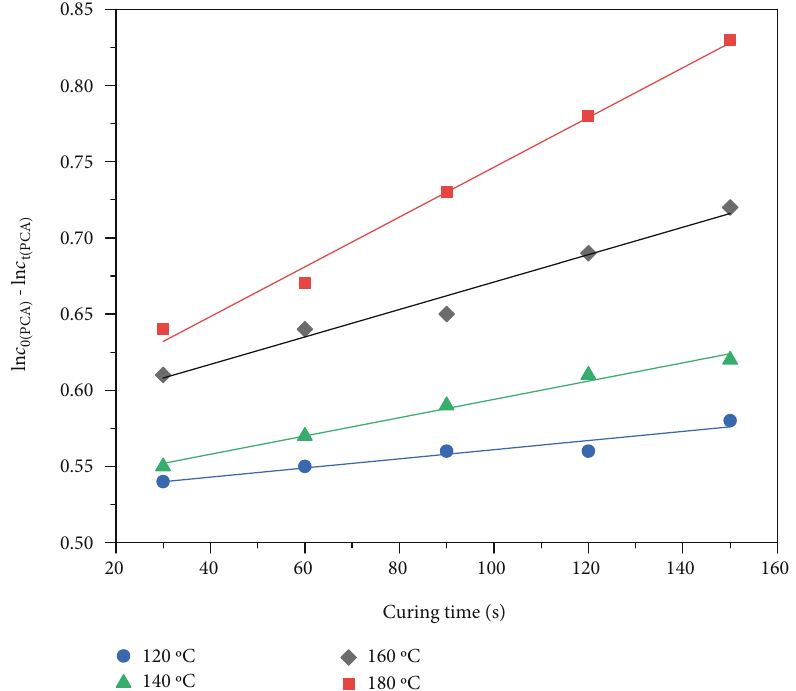
Figure 4: Plot of the esteri fi cation kinetics for the fi nishing system combining BTCA and CA under various